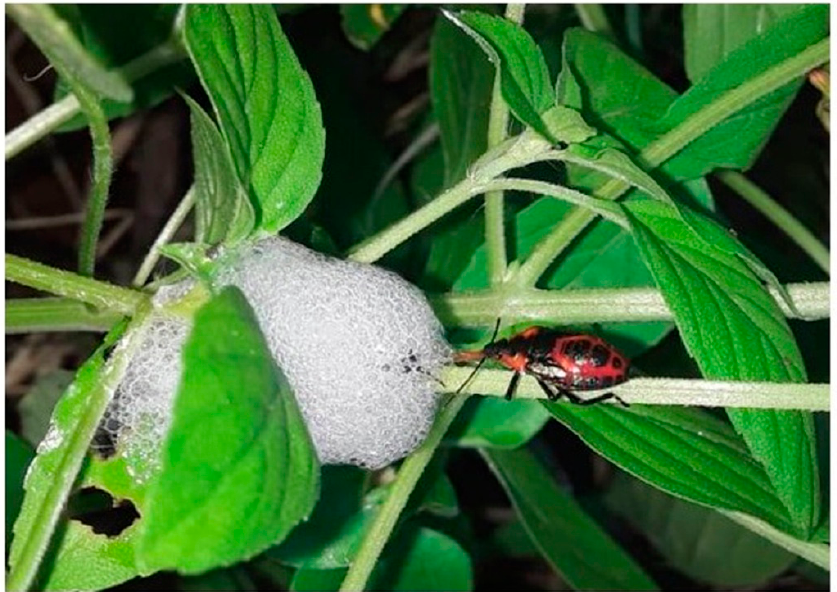
Figure 6. Feeding of a Pyrrhocoridae predator, Antilochus coqueberti (Heteroptera) nymph, on P. costalis nymph under field conditions.